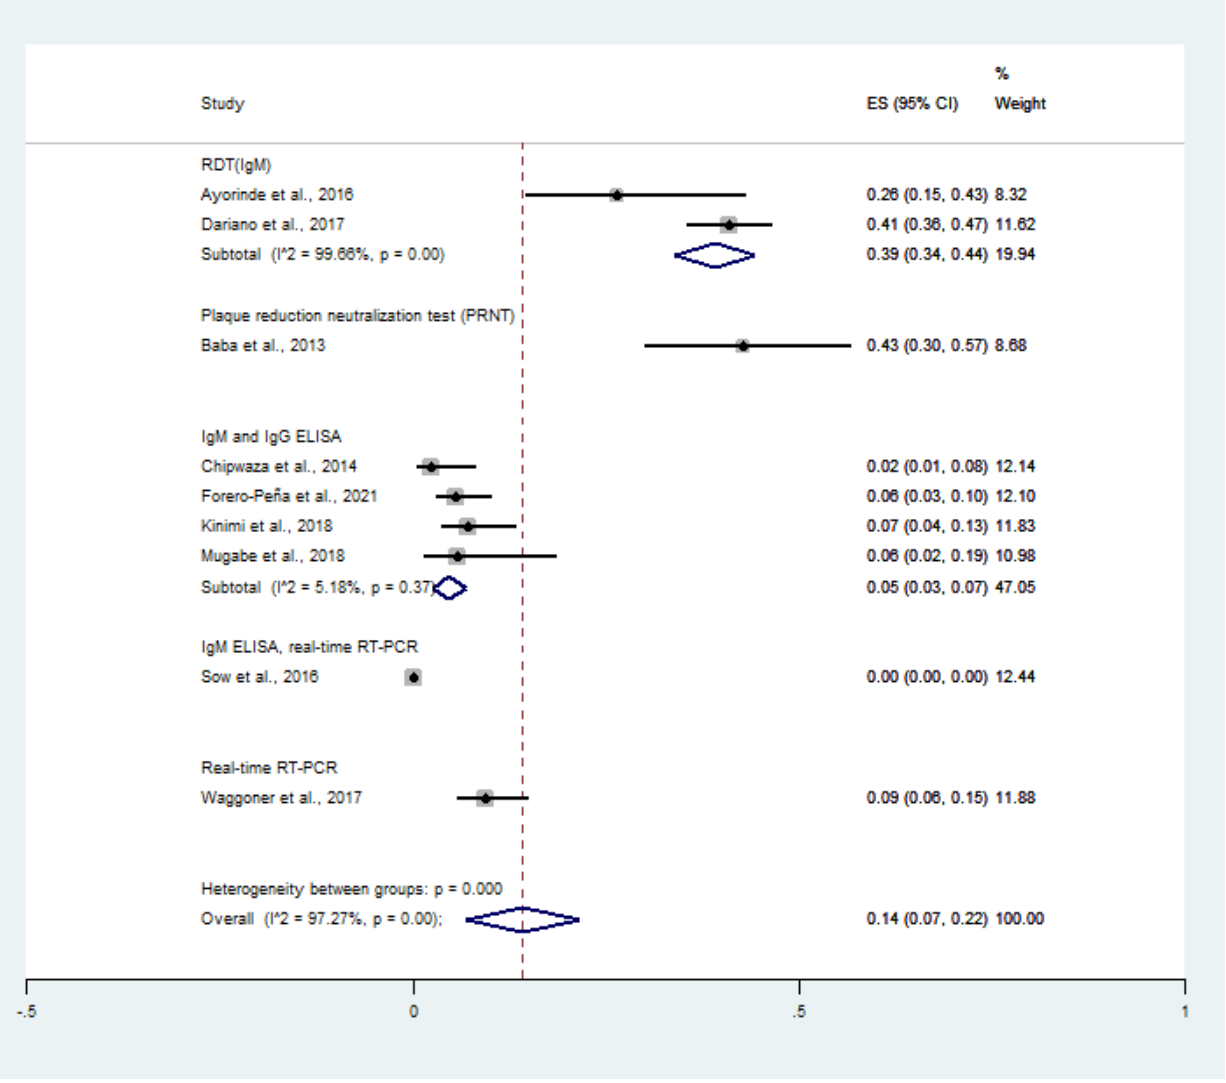
Figure 6. Prevalence of CHIKV infection among malaria patients by diagnostic tests: % weighted, the impact proportion of each study to the pooled effect; the black dot symbol on the black horizontal line, the point estimate for each study; the black horizontal line, CI; the white diamond symbol, the pooled prevalence; CI, confidence interval; ES, effect size (prevalence).